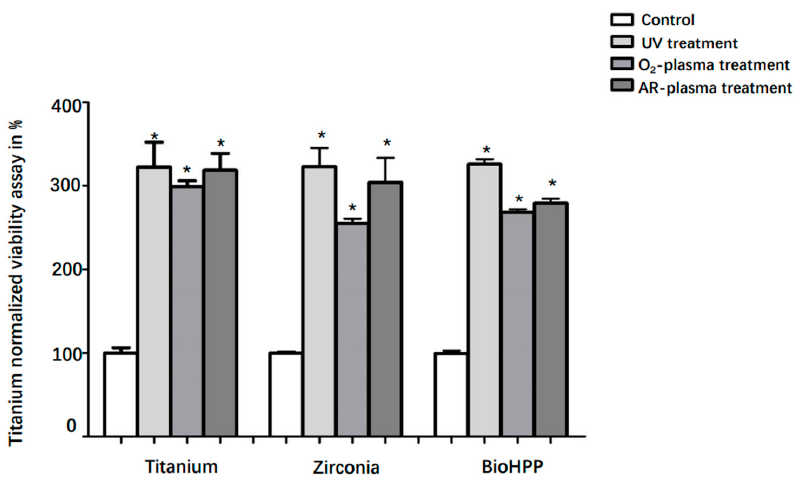
Figure 3. Viability of DPSCs on different surface treated titanium, zirconia and BioHPP after 24 h. Viability of DPSCs on controls and surface treated titanium, zirconia and BioHPP disks after 48 h of incubation was shown. Compared to controls, the viability of DPSCs on UV light, oxygen and argon plasma treated surfaces of titanium, zirconia and BioHPP was significantly increased ( p < 0.05). There were no significant differences between the treatments. * p < 0.05.